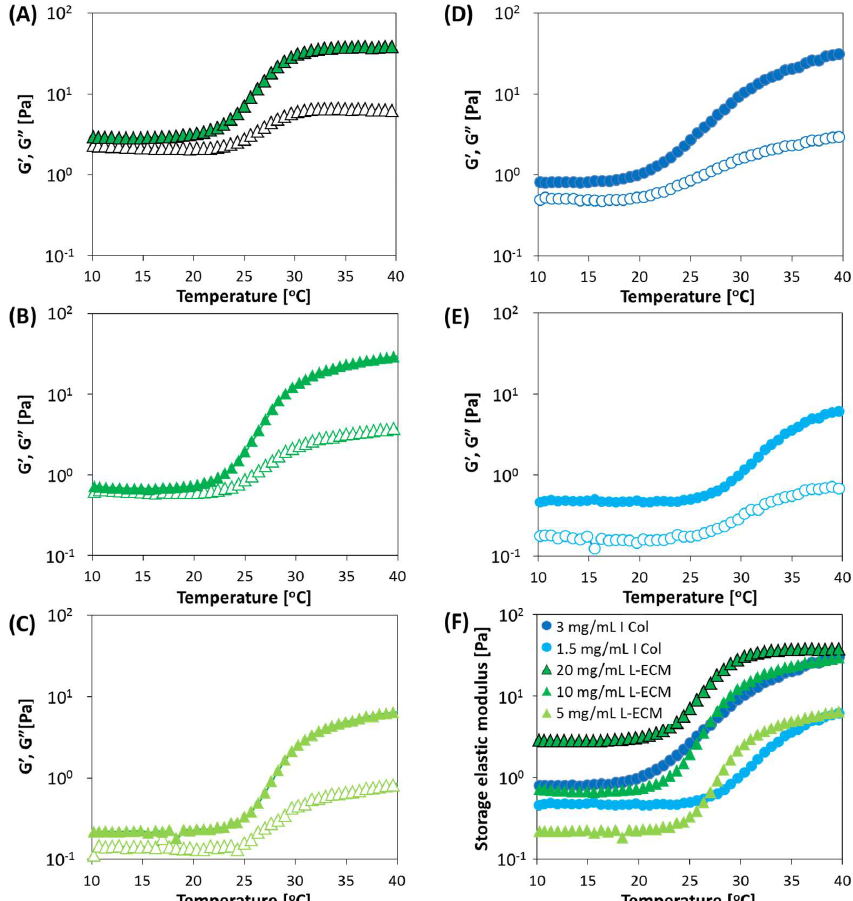
Figure 8. Change in G′ and G′′ at different concentrations of I Col (3 and 1.5 mg/mL) and L-ECM solutions (20, 10, and 5 mg/mL) with the rheometer measurements conducted in a DTR mode. ( A ) 20 mg/mL L-ECM, ( B ) 10 mg/mL L-ECM, ( C ) 5 mg/mL L-ECM, ( D ) 3 mg/mL I Col, ( E ) 1.5 mg/mL I Col, and ( F ) storage modulus for all tested conditions. ( A – E ) Open and closed symbols indicate storage and loss moduli, respectively (conditions of DTR: frequency, 1 Hz, and strain, 5%. Temperature was